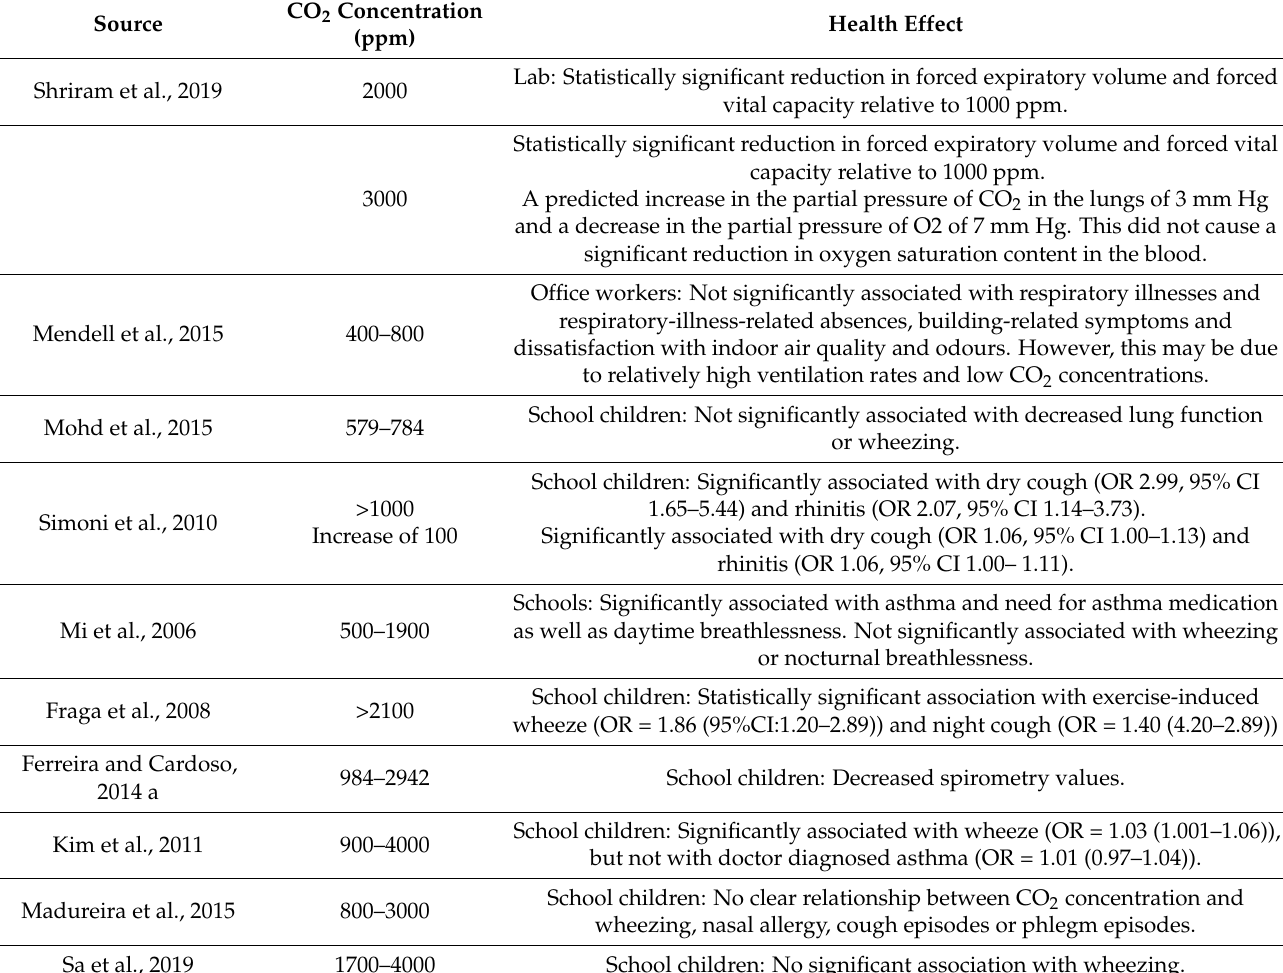
Table A3. A summary of primary research associating CO 2 with respiratory system